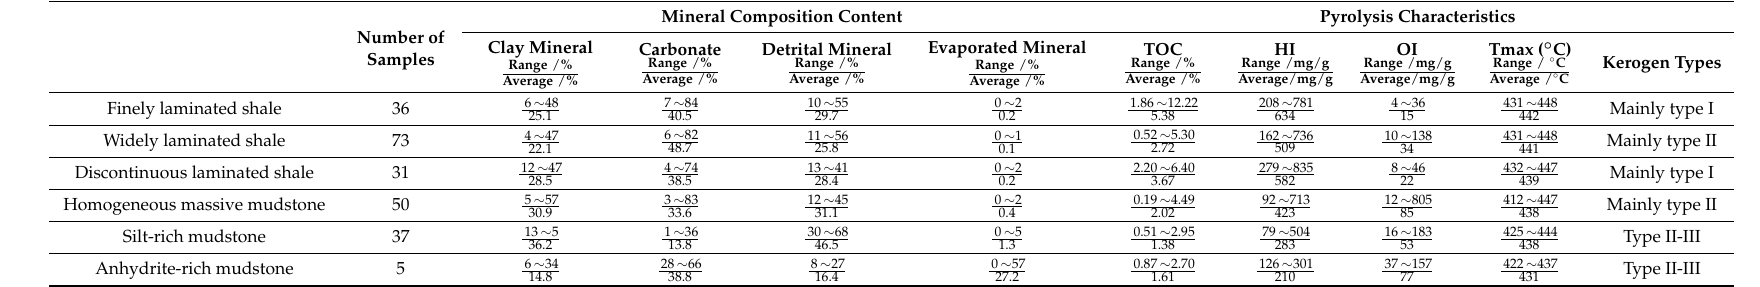
Table 1. Mineral composition contents and pyrolysis characteristics of each